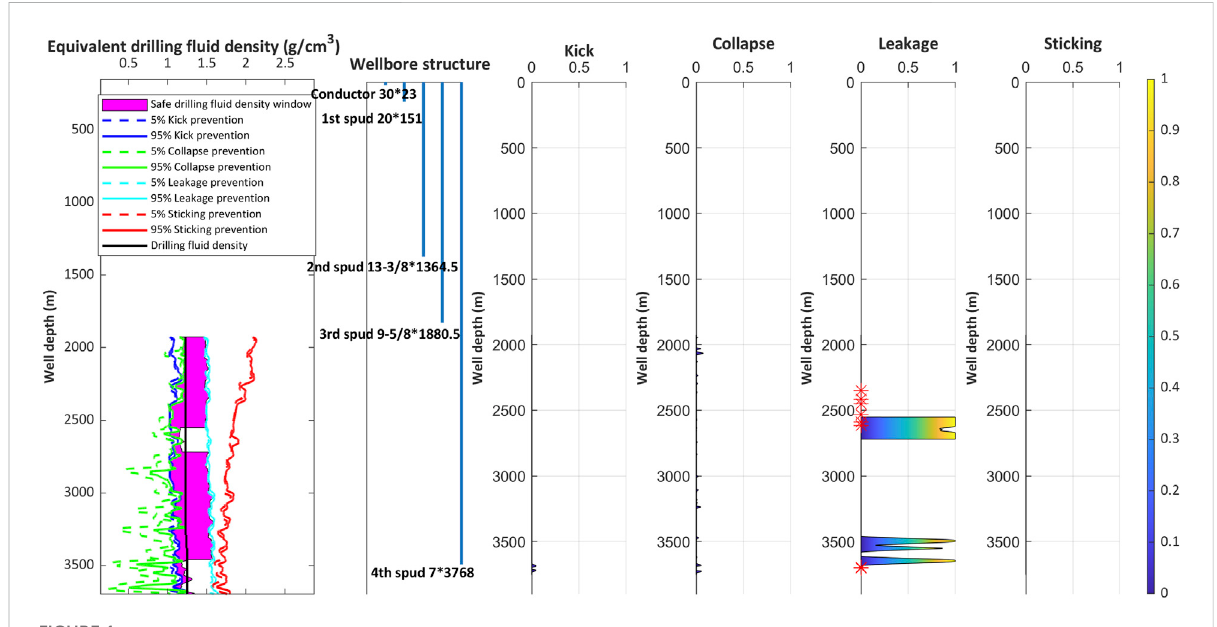
FIGURE 1 Safe drilling fl uid density window with credibility and risk intensity pro fi le.